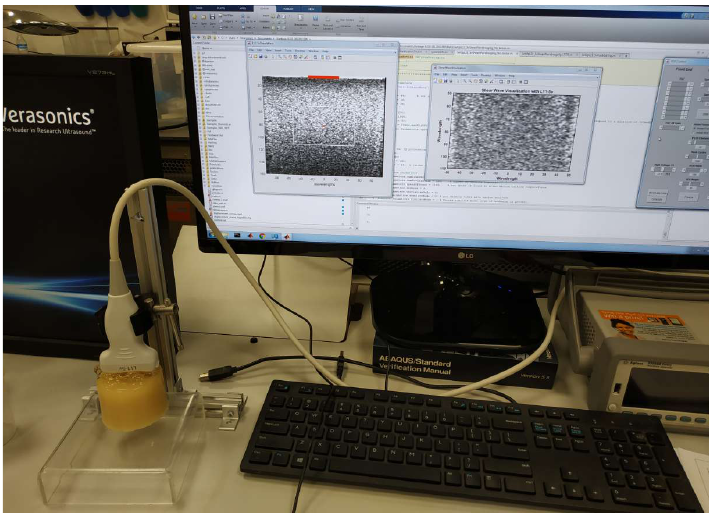
Figure 3. Experimental setup of Verasonics